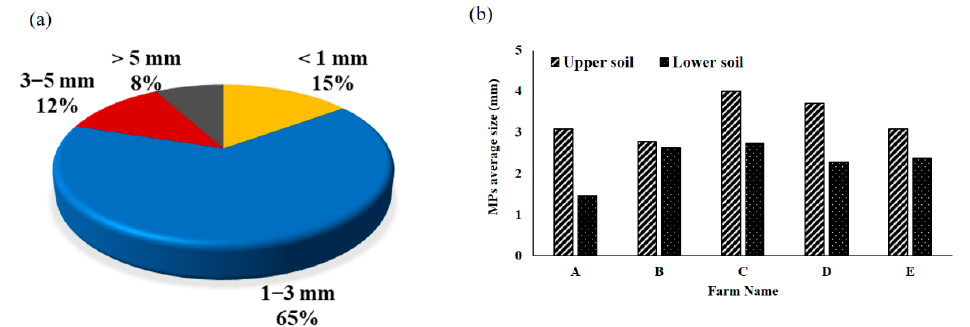
Figure 5. Size distribution of MPs in ( a ) all soil samples, and ( b ) in different farms under different depth.